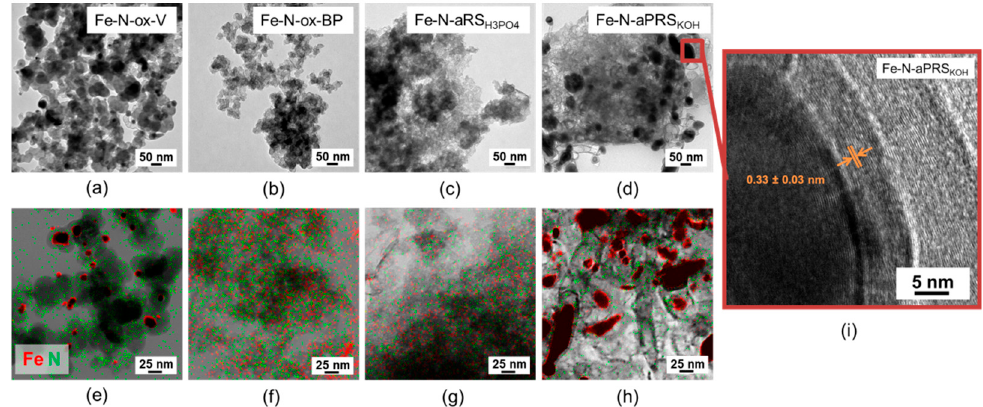
Figure 5. ( a – d ) TEM images; ( e – h ) High Resolution-TEM/EDS mapping of Fe and N of the four Fe-N-C materials, and ( i ) HR-TEM image with indicated lattice distance of Fe-N-aRS KOH .